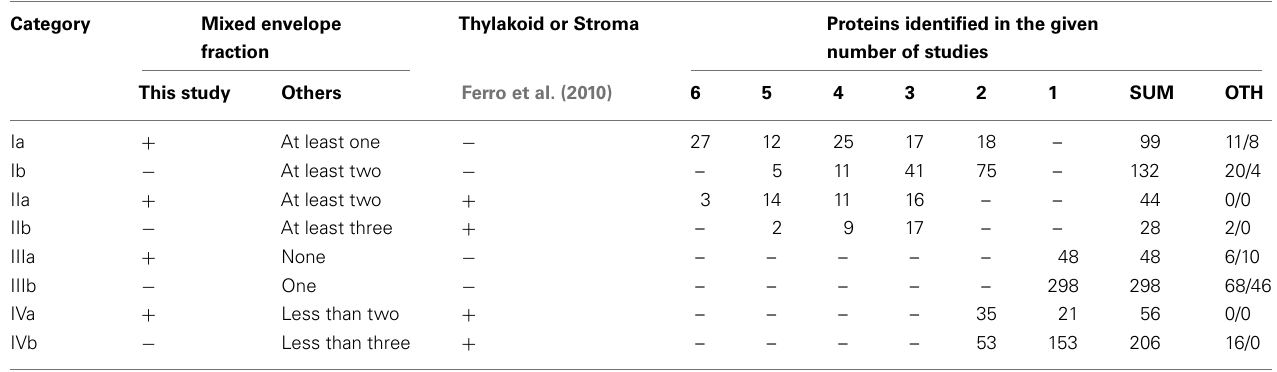
Table 1 | Categories for the classification of envelope membrane